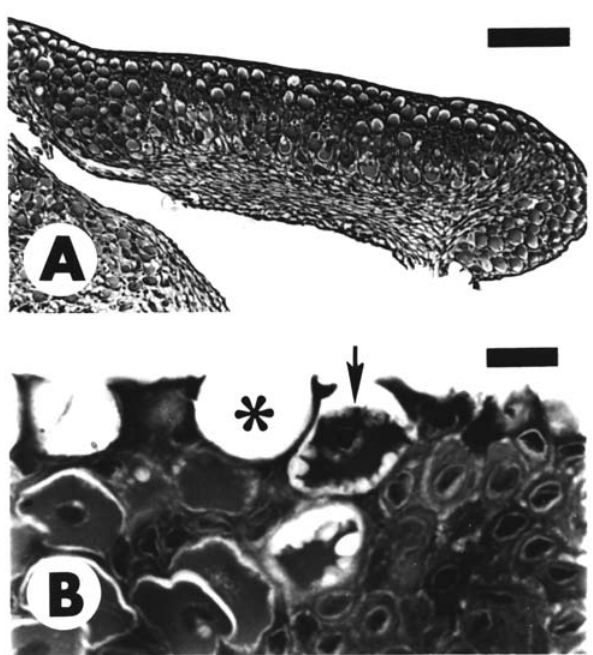
Fig. 21. Light micrographs through anal glandular tissue of mature male Bryconadenos tanaothoros . A, part of anal gland from a male of SL 36.6 mm (USNM 352061); bar, 100 µ m. B, High magnification of the anal gland of a male of SL 39.8 mm (USNM 352061) in the area of cell release showing a degener- ating cell (arrow) and a depression (*) remaining after cell release; bar, 10 µ